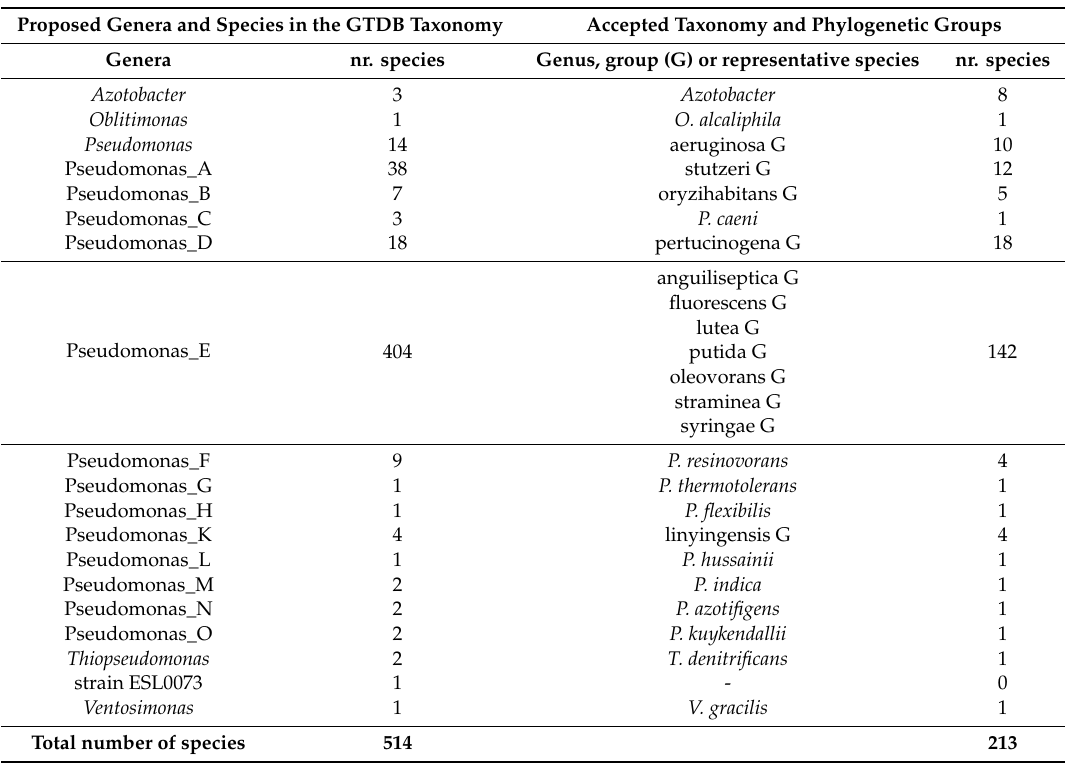
Table 2. Proposed genera defined by the GTDB taxonomy in the family Pseudomonadaceae compared with the currently recognized species, phylogenetic groups and genera based on the 4-genes MLSA. The number of species included in each group are also